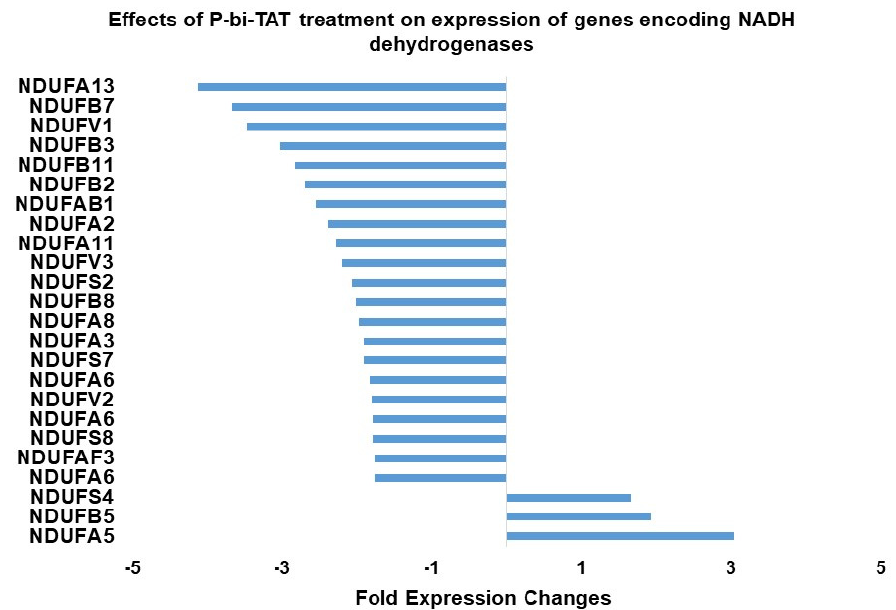
Figure 3. Effects of P-bi-TAT treatment on expression of genes encoding NADH dehydrogenases in primary GBM cells. Listed values report fold expression changes (log scale) for corresponding genes ( p < 0.05). Some genes are listed several times because the expression of these genes on the array is measured by the hybridization levels of several distinct probe sets designed to capture different transcript variants of the same gene. For every significantly affected gene, all transcript variants manifesting statistically significant expression changes are reported. All listed genes manifested significant changes in expression following P-bi-TAT treatment ( p < 0.05; see Methods).